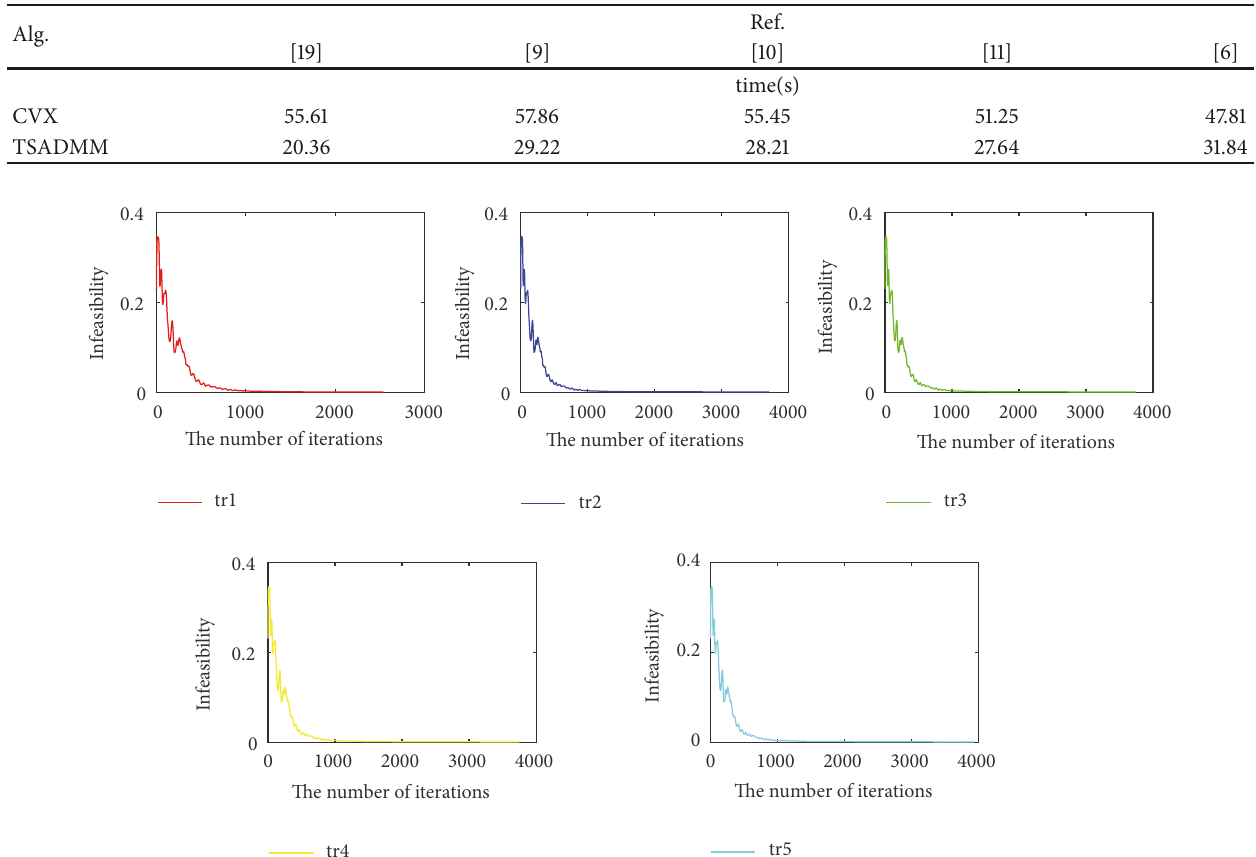
Figure 8: The numerical convergence behavior of TSADMM for different trip times: tr1, .. . ,tr5 stand for the cases for different trip times proposed in [6, 9–11,